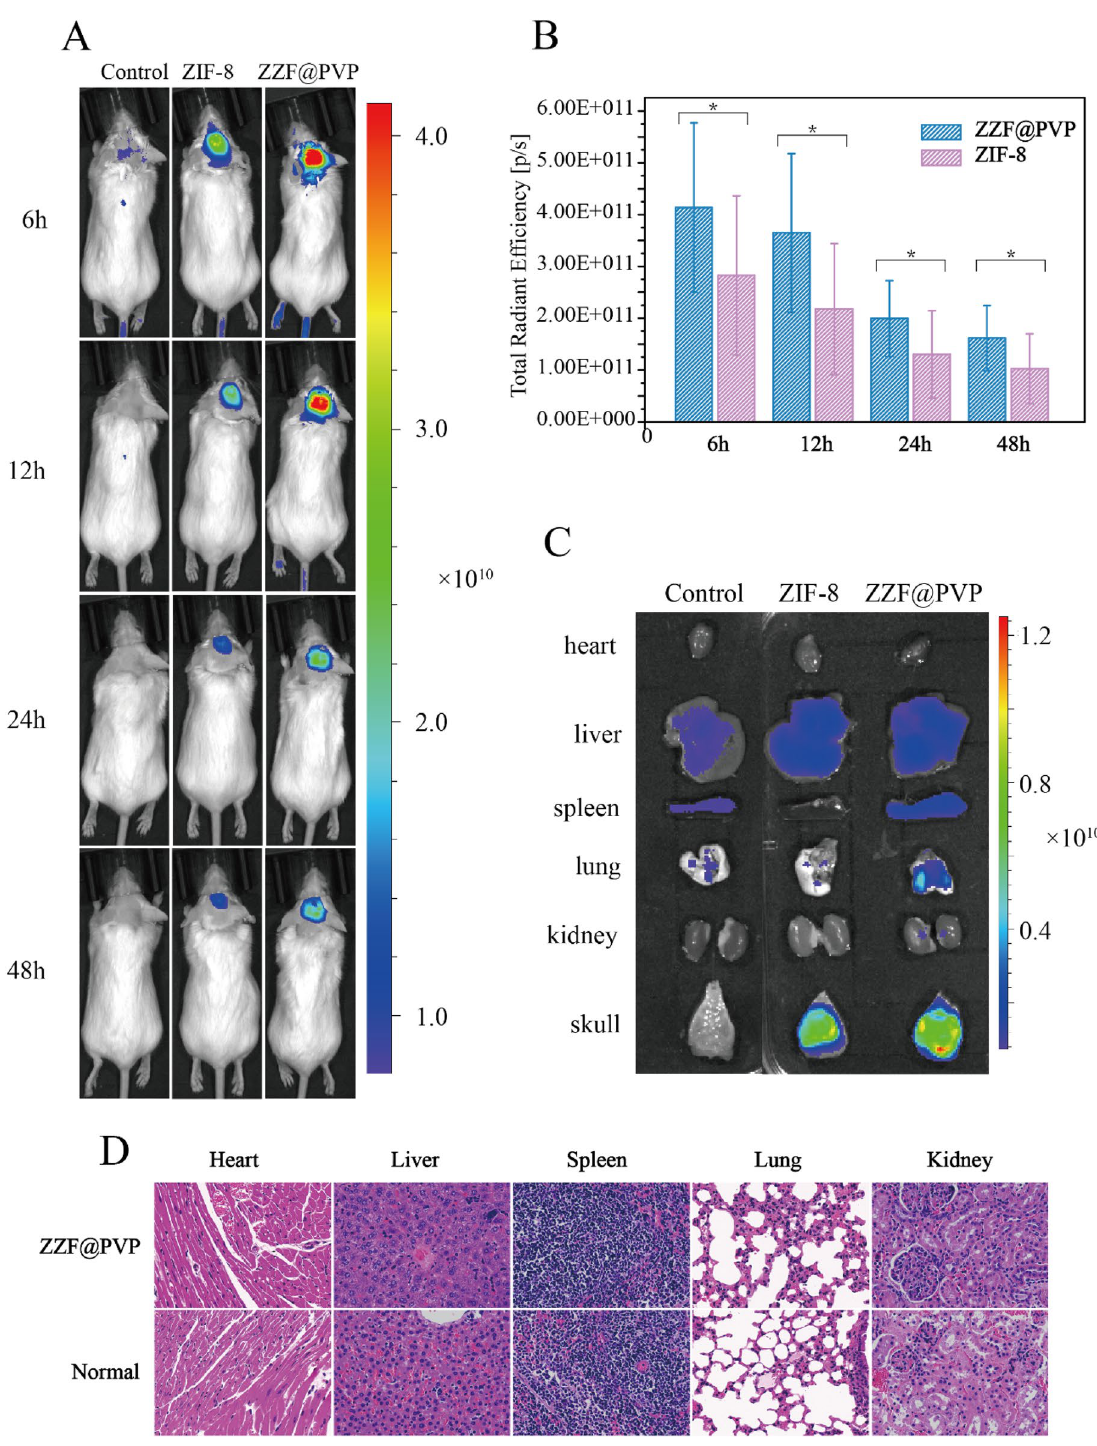
Figure 6. ( A ) Living fluorescence imaging of mice from control, ZIF-8, and ZZF@PVP groups at different time points after injection. ( B ) Total radiant efficiency analyses of the surgery area between the control, ZIF-8, and ZZF@PVP groups at 6, 12, 24, and 48 h after injection. ( C ) Representative fluorescence images of ex vivo heart, liver, spleen, lung, kidney, and skull of mice from the three groups at day 5 after intravenous injection. ( D ) H&E stain of major organs of ZZF@PVP group mice at day 5 after a single injection of